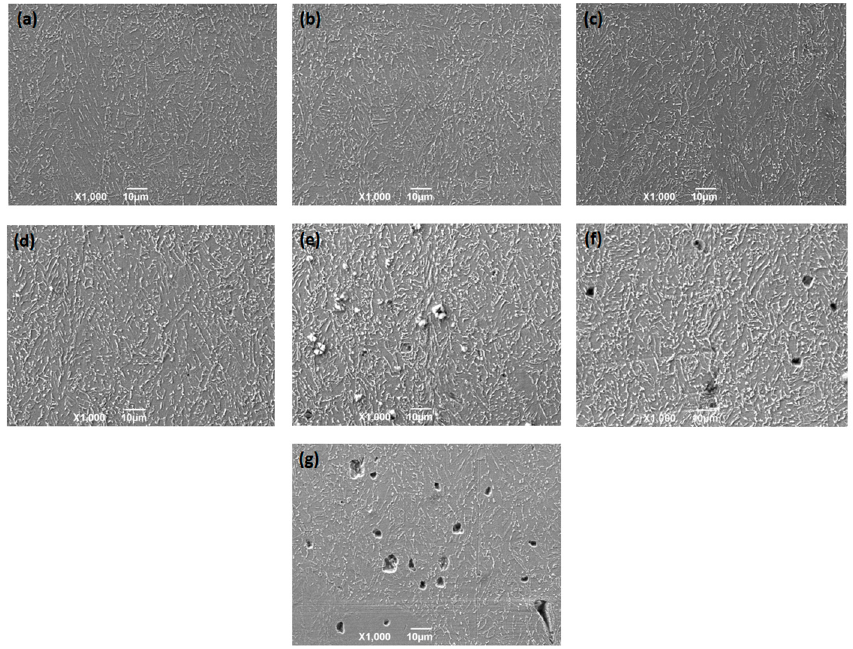
Figure 11. Scanning electron microscope (SEM) photographs of corroded surface of X80 steel in 3.5 wt% NaCl aqueous solution with saturated CO 2 at 30 ◦ C under different tensile stress: ( a ) 0% σ ys ; ( b ) 30% σ ys ; ( c ) 60% σ ys ; ( d ) 90% σ ys ; ( e ) 103% σ ys ; ( f ) 105% σ ys ; and ( g ) 108% σ ys